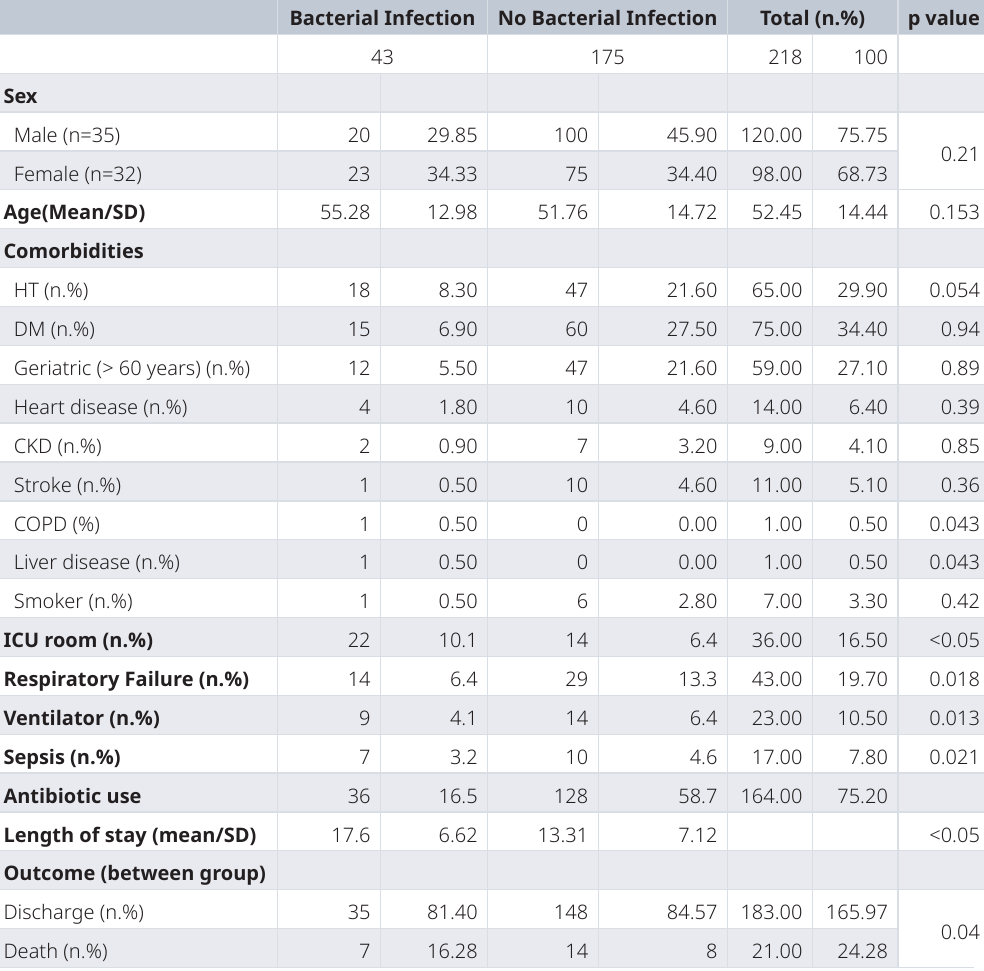
Table 2. Comparison of COVID-19 patients who had bacterial infections and without bacterial